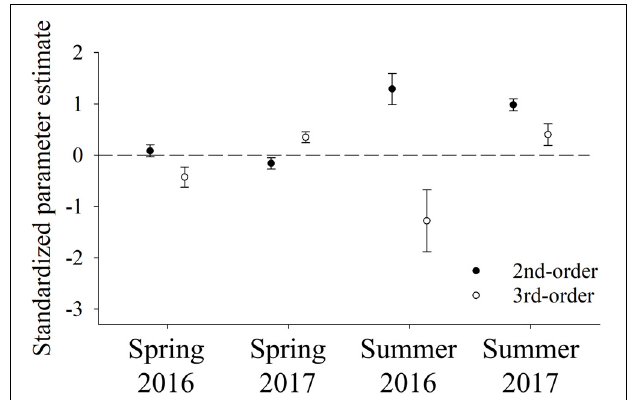
FIGURE 4 | Standardized parameter estimates ( β ) and associated 90% confidence intervals from 2nd- and 3rd-order resource selection functions that quantified the influence of forage biomass (i.e., biomass of selected and neutral forage plants) on space use by female mule deer during spring (13 May–30 June) and summer (1 July–11 August), 2016 ( n = 18) and 2017 ( n = 13), at the Starkey Experimental Forest and Range, Oregon, United